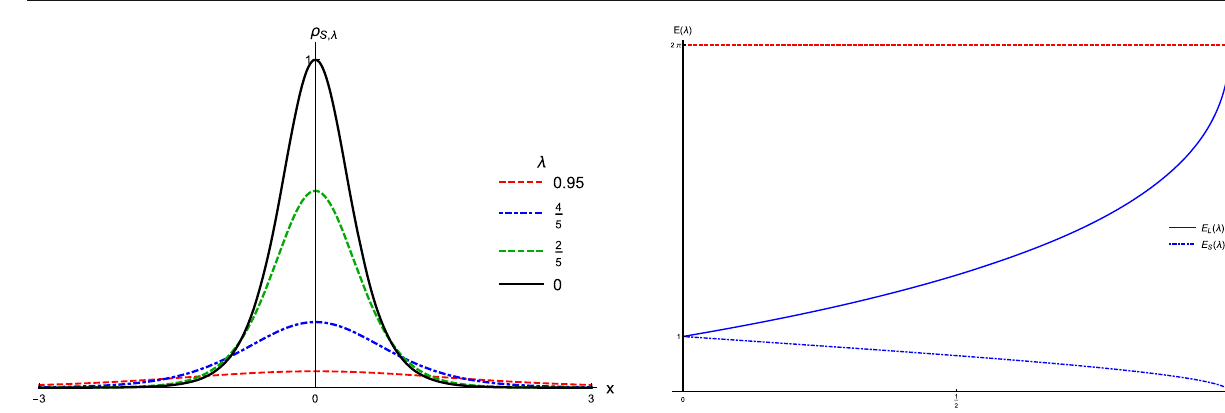
Fig. 6 The energy behavior as a function of λ . Here we observe that E L (λ) evolves from E L ( 0 ) = 1 to E L ( 1 ) = 2 π and E S (λ) decreases from E S ( 0 ) = 1 to E S ( 1 ) =